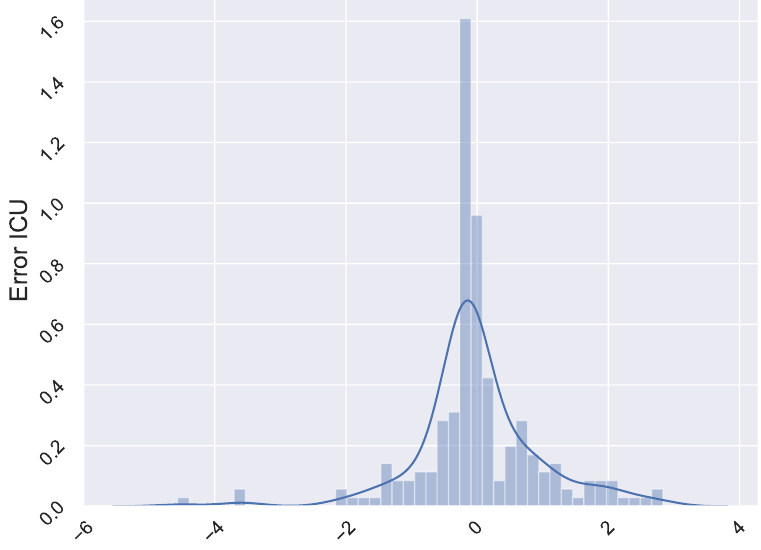
Figure A2. White noise histogram of AR model for ICU residual